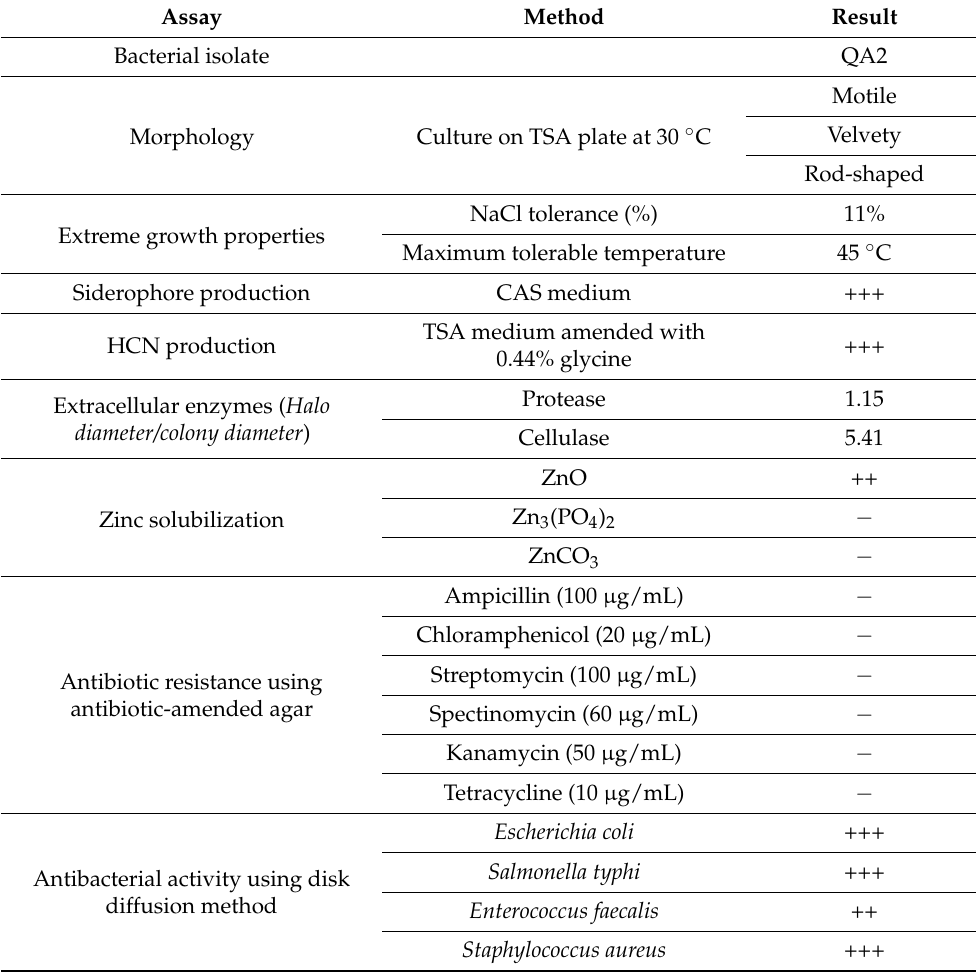
Table 2. Summary of some morphological, physiological, and biochemical characters of the QA2 isolate using plate assays.